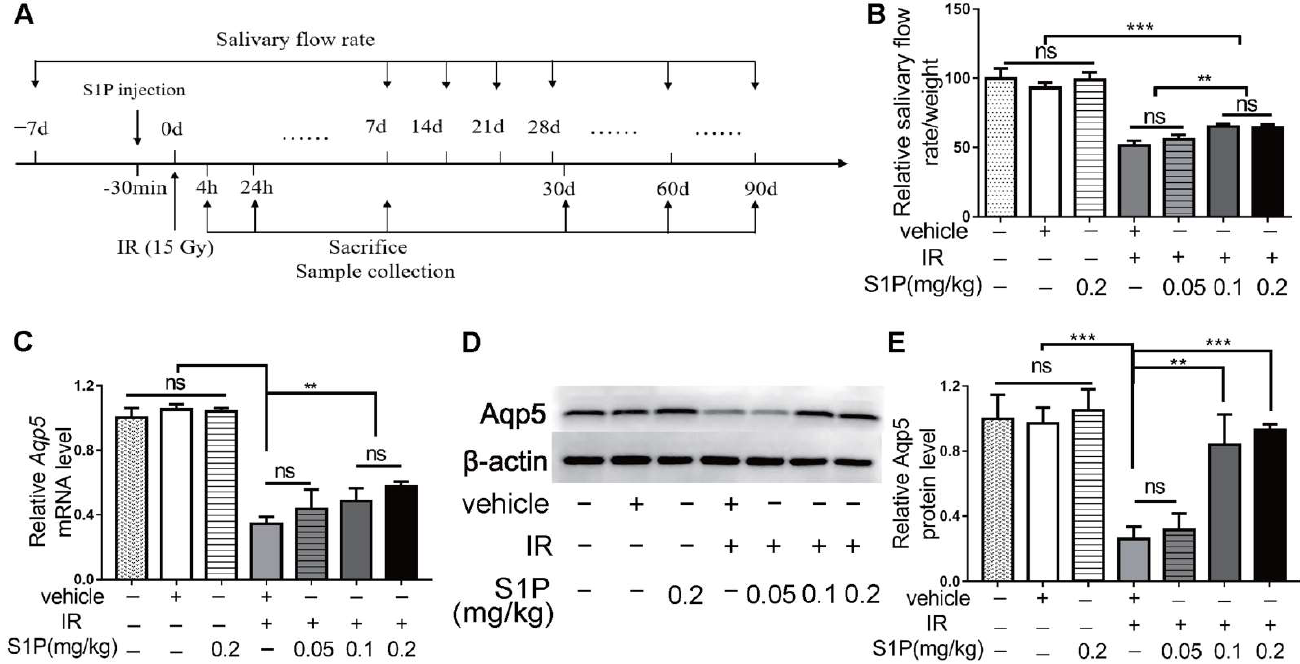
Figure 1. Locally injected S1P prevented irradiation damages on salivary gland function. ( A ) The experimental design. ( B ) The pilocarpine-stimulated whole salivary flow rate was measured 7 days before and 7, 14, 28, 60 and 90 days after IR (N = 6). ( C – E ) RT-qPCR and Western blot analysis of Aqp5 level in SMGs collected at 90 days after IR (N = 3). Data are expressed as mean ± SD, **: p < 0.01, ***: p < 0.001, ns: not significant. Quantitative data were analyzed using one-way ANOVA with Tukey’s multiple comparisons.